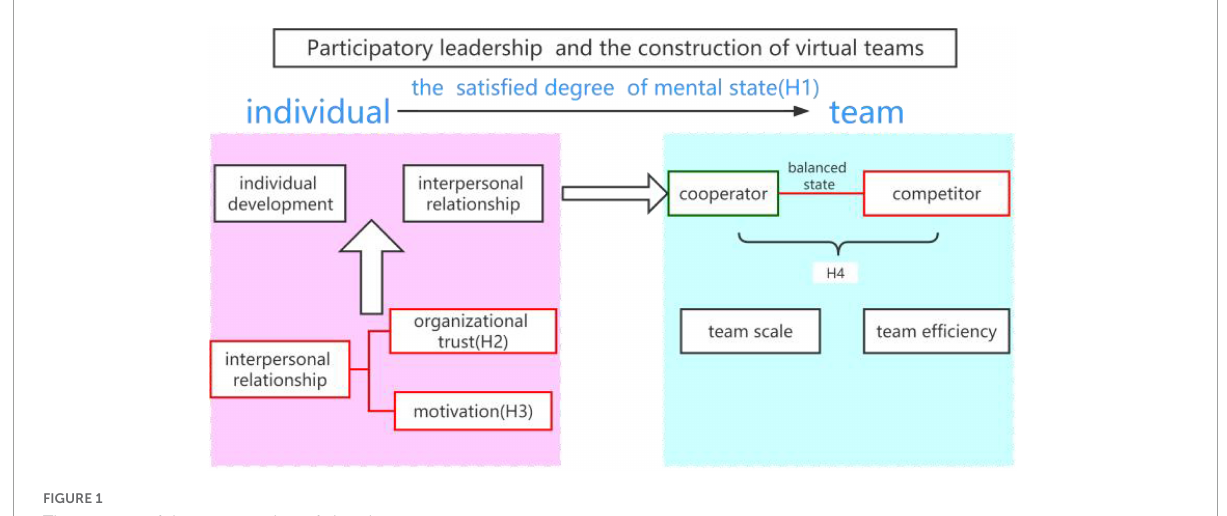
FIGURE1 The process of the construction of virtual